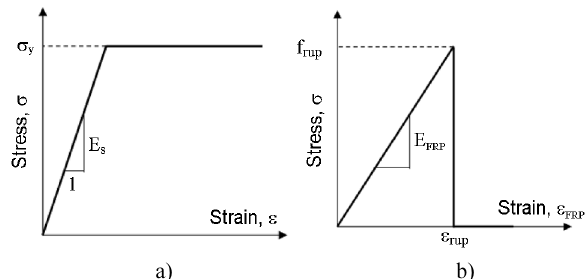
Fig. 7. Material models for (a) steel and (b) FRP composites